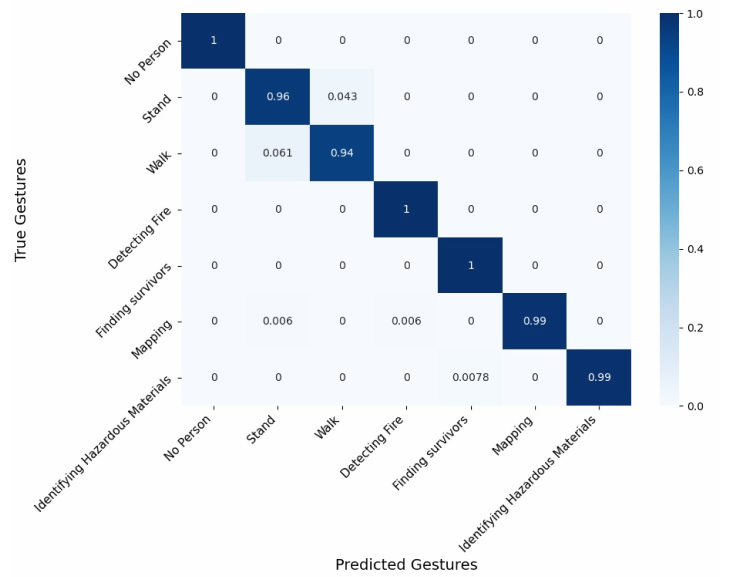
Figure 8. Confusion matrix for the RGB sensor with skeleton extraction + SVM, without smoke, and without